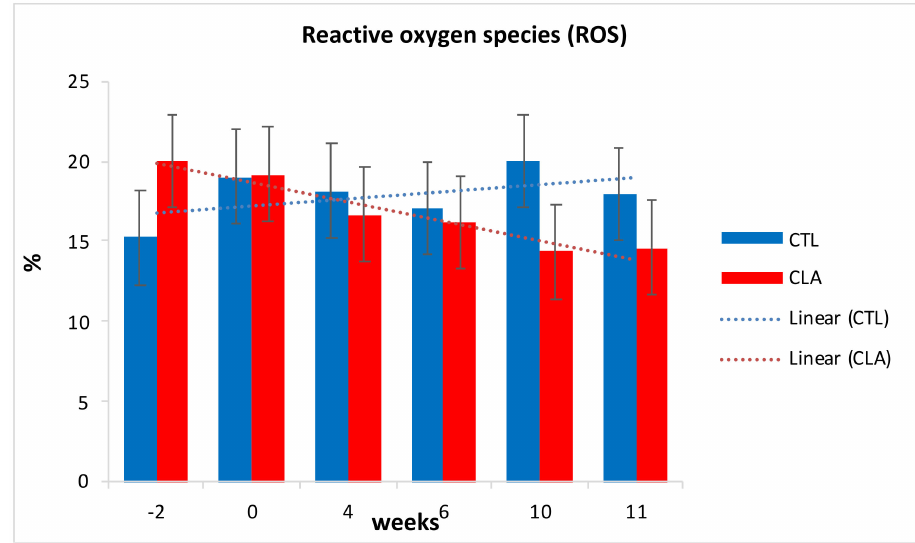
Figure 6. Effect of CLA dietary supplementation on post-thawed bovine semen flow cytometer analysis of percentage of reactive oxygen species ROS (LSM ± SE), for control (CTL) and CLA group.